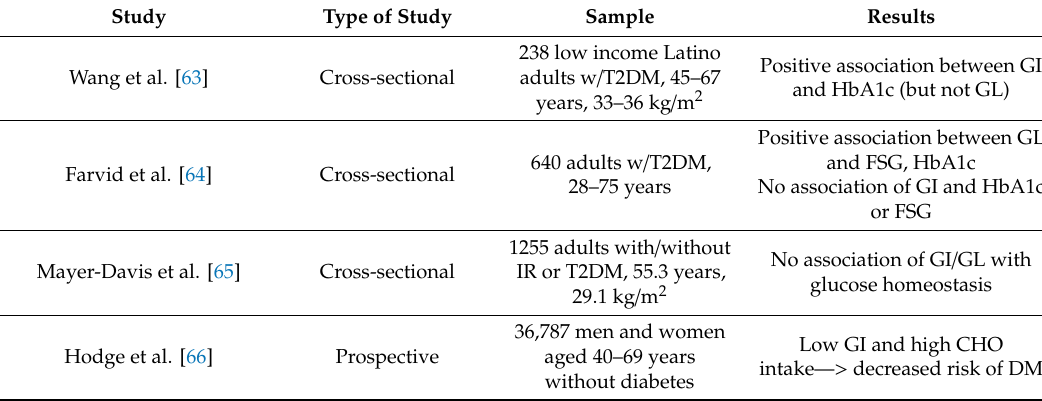
Table 1. Major studies and meta-analyses on the association of glycemic index and glycemic load with glycosylated hemoglobin A1c; FSG, fasting serum glucose; CHO, carbohydrates; CHD, coronary heart disease; DM, diabetes mellitus; RR, relative risk;IR, insulin